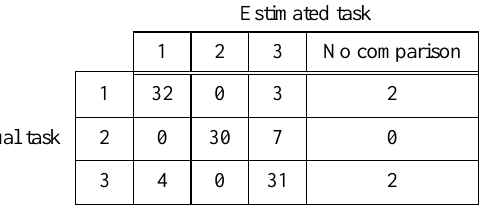
Table 2. Results of estimation of participants’ interest (en- gaging task). Number in each cell in column 𝑟 (𝑟 = 1,2,3) shows the number of sessions that were estimated as engaged task 𝑟 . “ No comparison” means the AOF detection step could not detect a bias of gaze behavior during the